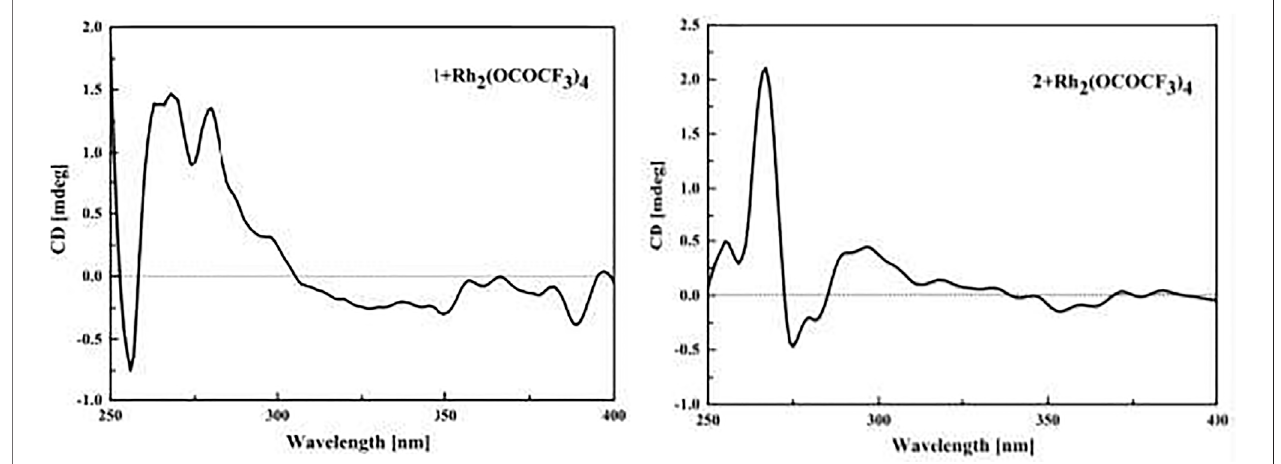
FIGURE 3 | ECD spectra of the Rh complex of 1 and 2 with the inherent ECD spectra subtracted.